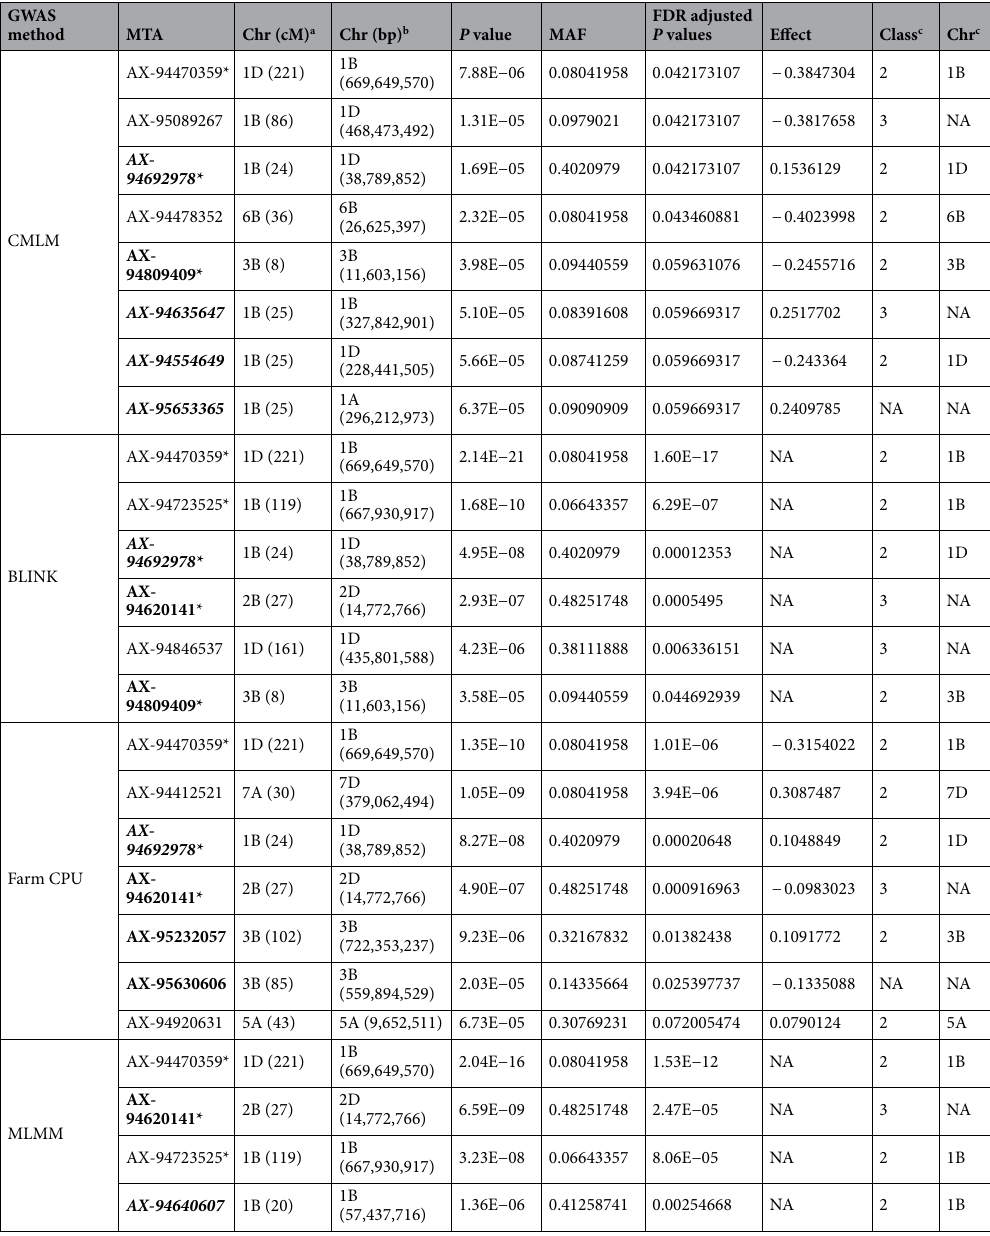
Table 1. Details of significant MTA [− log10 ( p value) > 4.0] obtained using different GWAS methods along with other details. a Chromosome and genetic position in centimorgan as per 104 . b Chromosome and physical position in base pairs as per IWGSC and 35K chip data information. c Classification of SNP and potential chromosome on which this SNP is located as per 109 . NA: Not available. *MTA detected through more than one method. Non-bold format represent novel MTA detected in the present study. Bold format represent MTA underlying in QTL region for P. thornei and P. neglectus resistance as reported previously (shown in Supplementary Table S5). Bold and italic format represents MTA detected near (~ 10.0 cM) to already identified marker regions for P. thornei and P. neglectus resistance through GWAS (shown in Supplementary Table